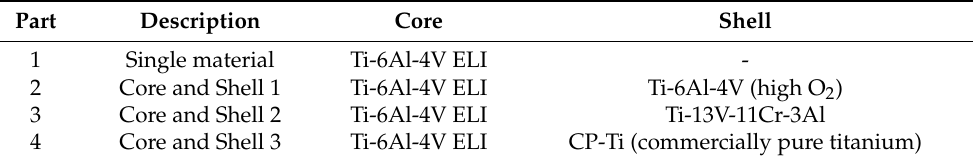
Table 1. Initial billet material condition.